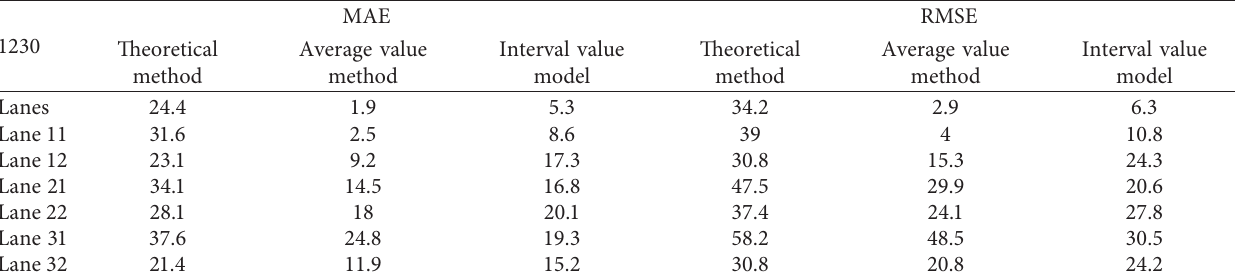
Table 8: Data fitting accuracy by MAE and RMSE on December 30,